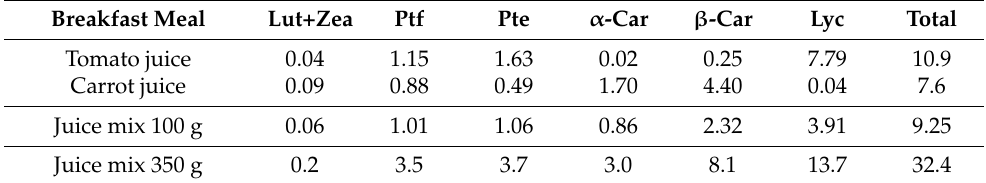
Table 3. Carotenoid contents (mg/100 g) of the tomato and carrot juices 1 , as determined by HPLC. Breakfast